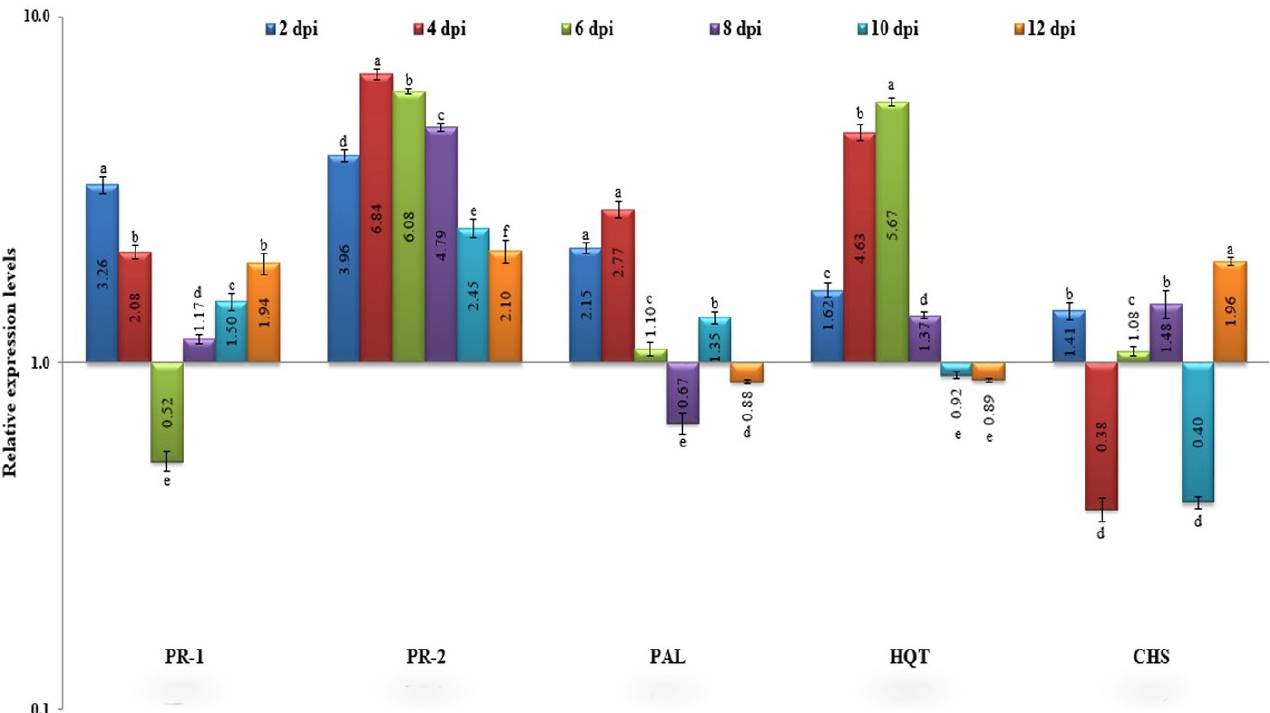
Figure 3. Relative expression levels of PR-1 , PR-2 , PAL , HQT , and CHS genes upon CMV infection from 2–12 dpi. The columns reflect the means of biological triplicates, while the bars represent the standard deviation (±SD). Small letters indicate changes between samples that are statistically significant. Values of columns with the same letter do not differ significantly.